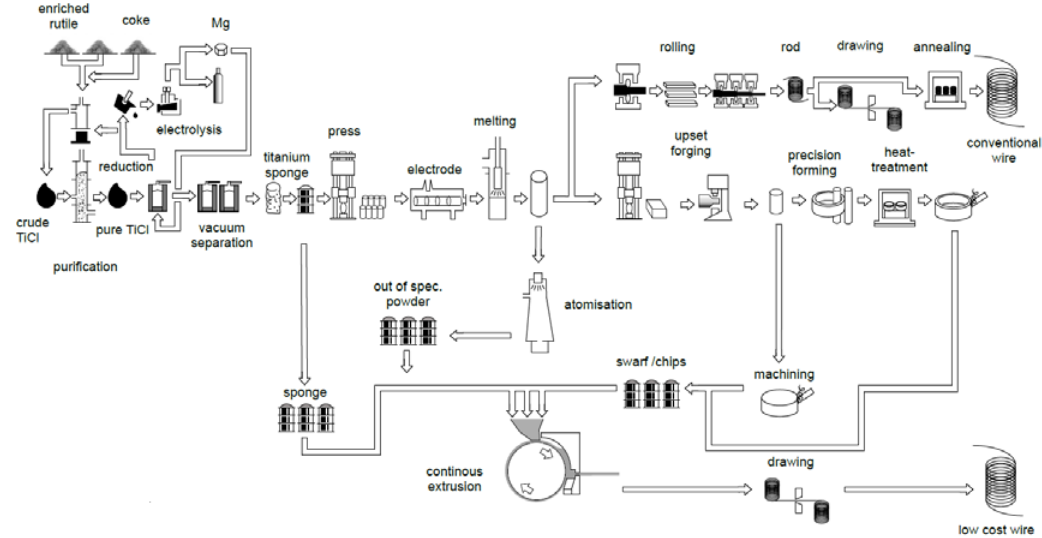
Figure 3. Schematic demonstrating the various wire production routes commonly used and the potential feedstocks identified for investigation into low-cost wire production by using the disruptive technology of Conform TM .